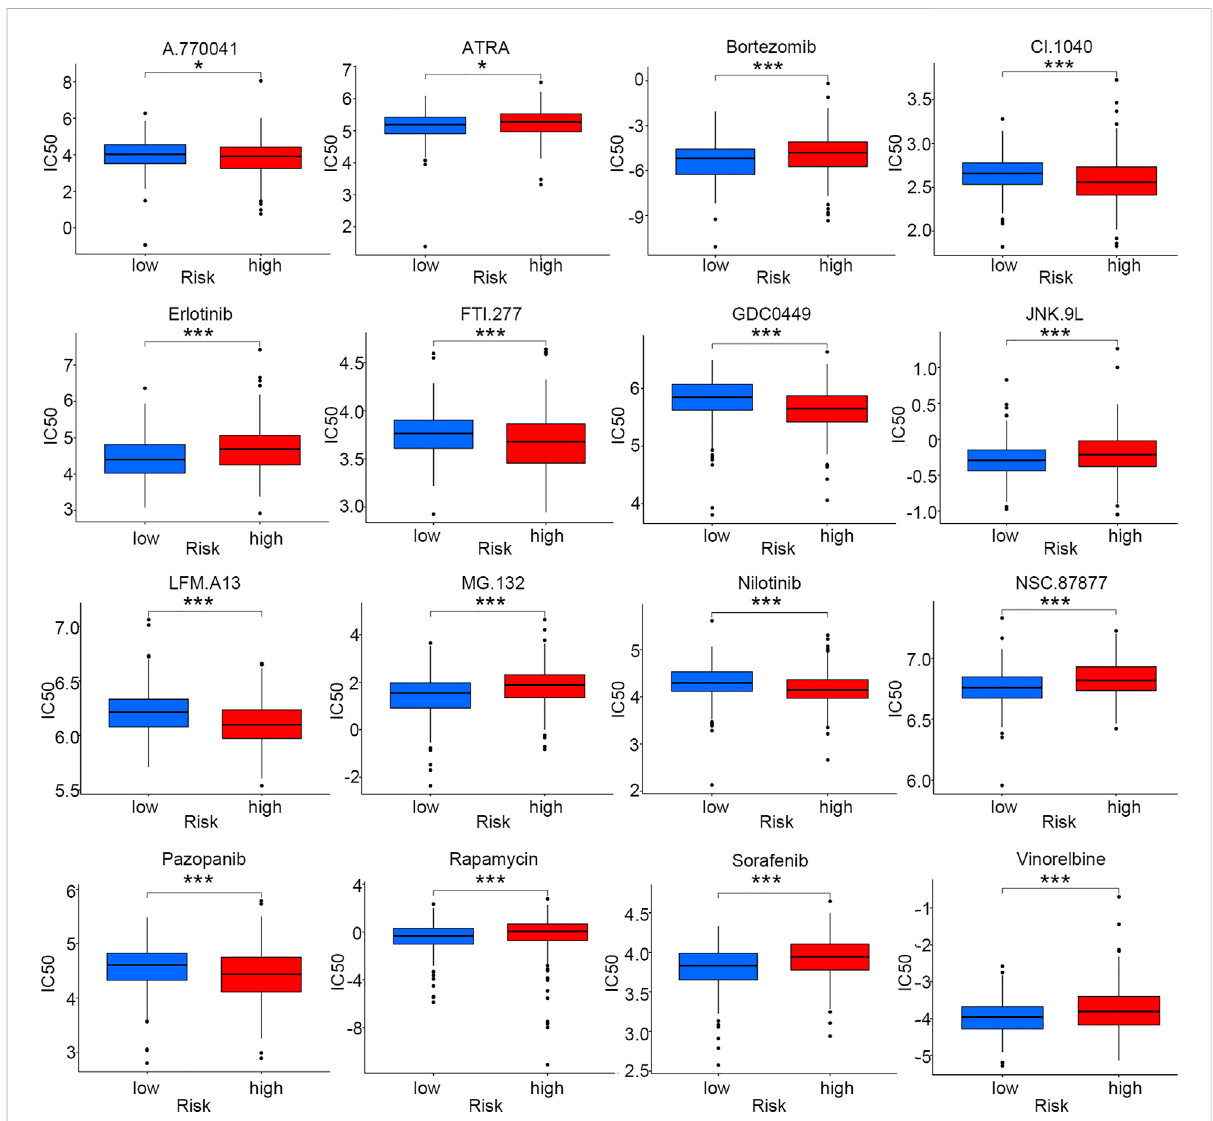
FIGURE 7 Drug sensitivity comparison for smoking-associated LUSC patients between low- and high-risk groups (* p < 0.05; *** p <